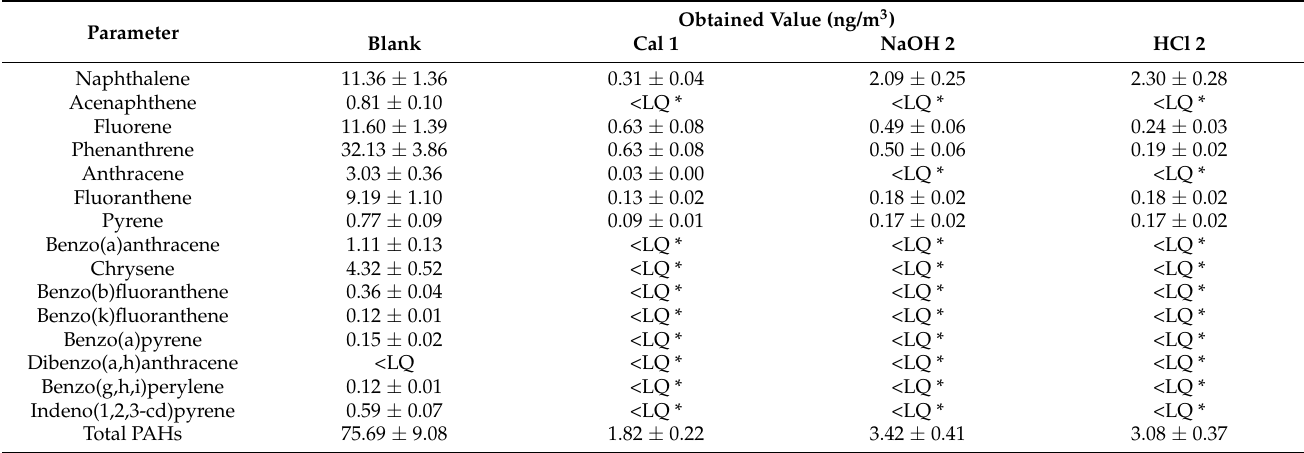
Table 9. Results for samples taken on PM10 particulate filter.